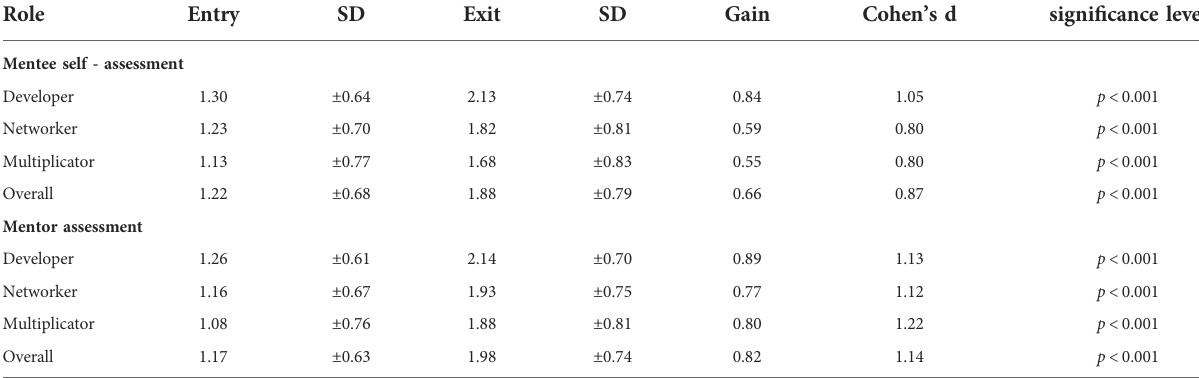
TABLE 2 Mentee competency changes during the mentoring